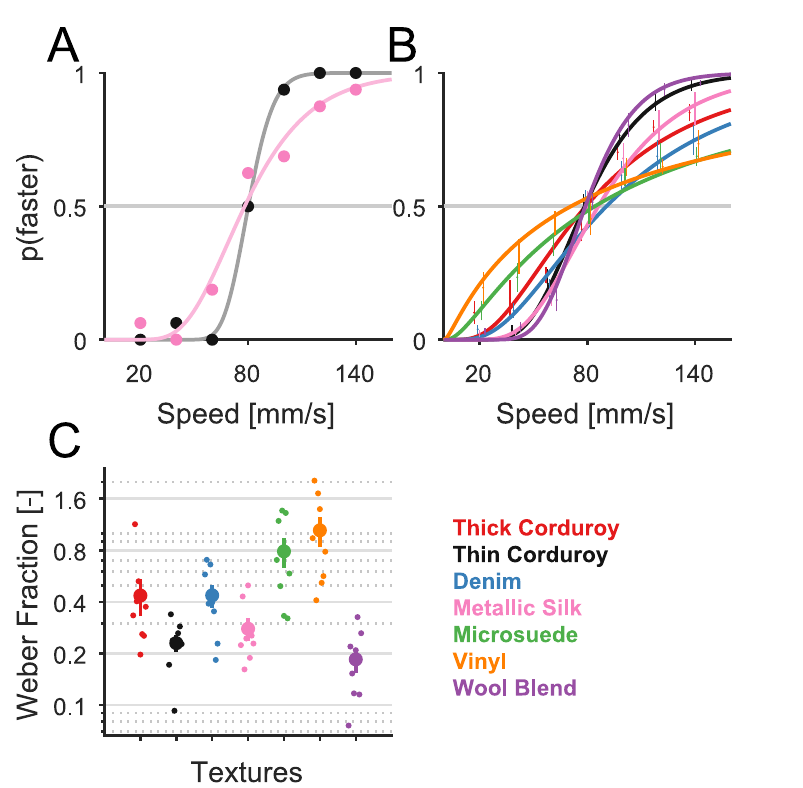
Fig 2. Speed discrimination within texture. (A) Discrimination performance—as gauged by the proportion of trials judged faster than the reference (at 80 mm/s) versus speed—of an example subject for “thin corduroy” (black) and “metallic silk” (pink). (B) Performance averaged across subjects for all tested textures ( n = 8 subjects for each texture). Error bars denote the SEM. (C) Weber fraction obtained from individual subjects (small dots) along with the respective means ± SEM (large dots and bars). Data underlying this figure can be found in S1 Data.